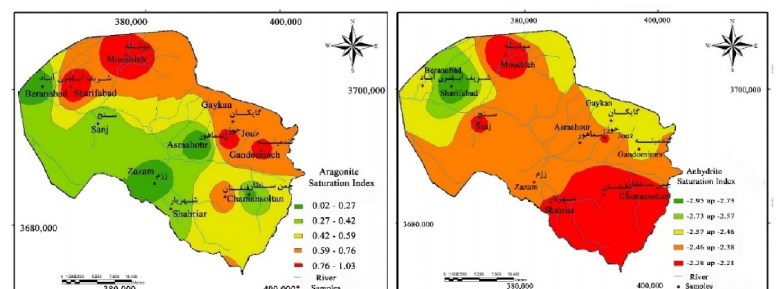
Fig. 3. The saturation Index map of Aragonite and Anhydrite of the study area